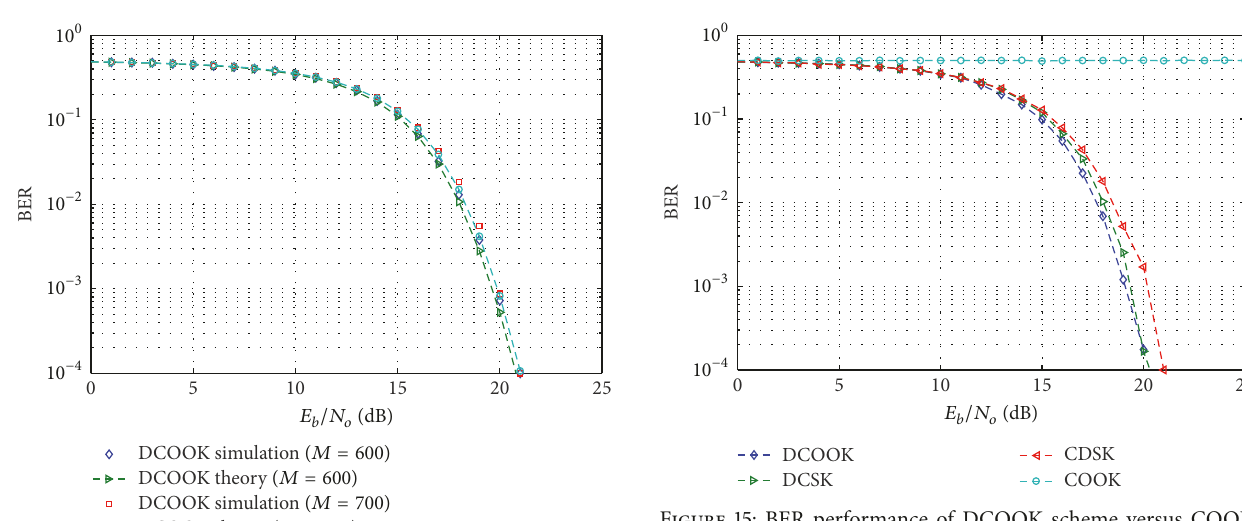
Figure 15: BER performance of DCOOK scheme versus COOK, DCSK, and CDSK scheme at 𝑀 = 600 .